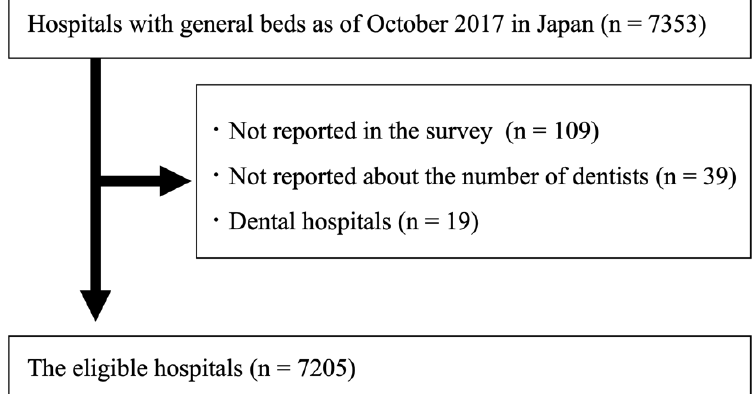
Figure 1. Flow chart of the eligible hospitals in the present study.